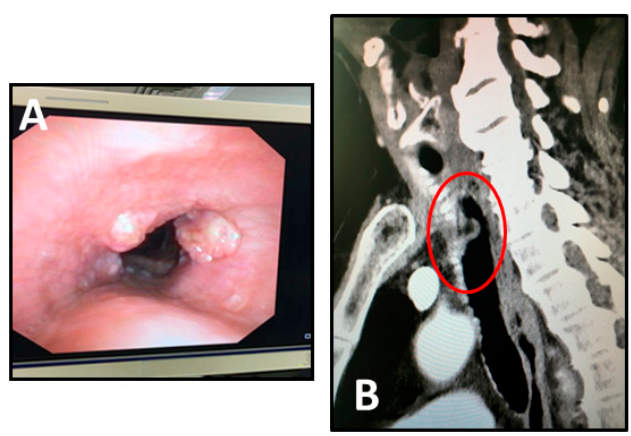
Figure 1. Preoperative evaluation after induction chemotherapy: ( A ) bronchoscopic view of middle tracheal cancer; ( B ) chest CT scan showing a mass (round), measuring about 30 mm along the longitudinal axis of the trachea, involving the anterior wall of the mediastinal trachea.